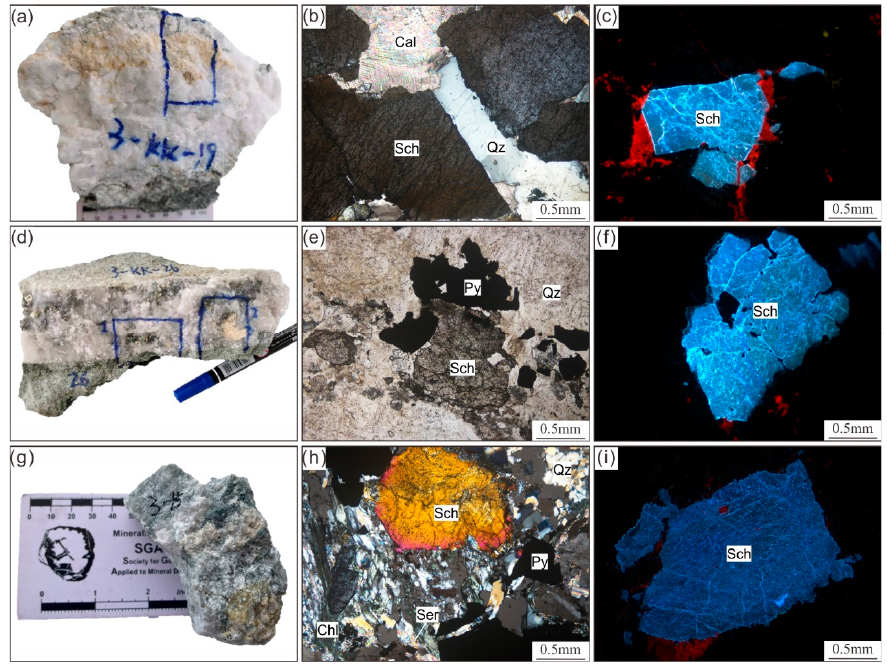
Figure 3. Characteristics of scheelites from different ores of the Doranasai gold deposit. ( a – c ) scheel- ite in early-stage milky quartz veins; ( d – f ) scheelite in middle-stage quartz–polymetallic sulfide veins; ( g – i ) scheelite in altered albite veins; Py—pyrite; Sch—scheelite; Qz—quartz; Chl—chlorite; Ser—sericite;